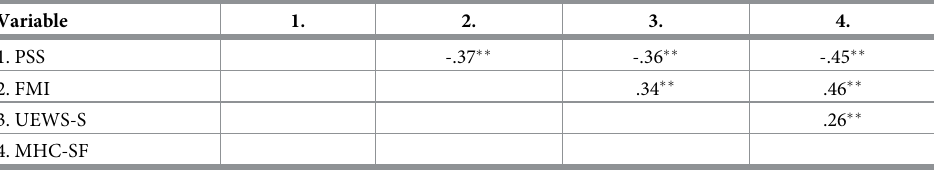
Table 2. Pearson product-moment correlations for PSS, FMI, UEWS-S, and MHC-SF change scores. Variable